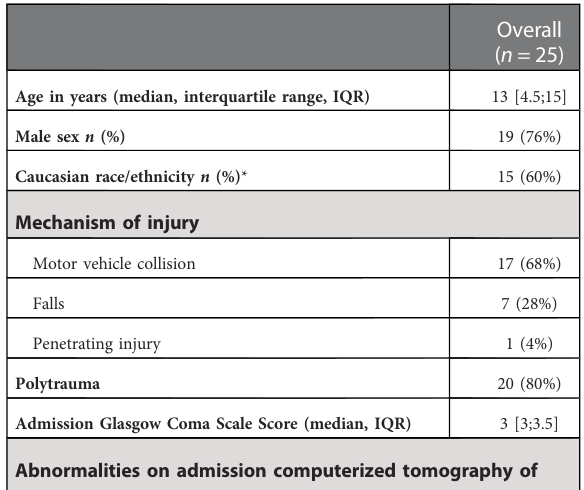
TABLE 1 Characteristics of hospitalized children with traumatic brain injury who underwent clinical cerebral autoregulation